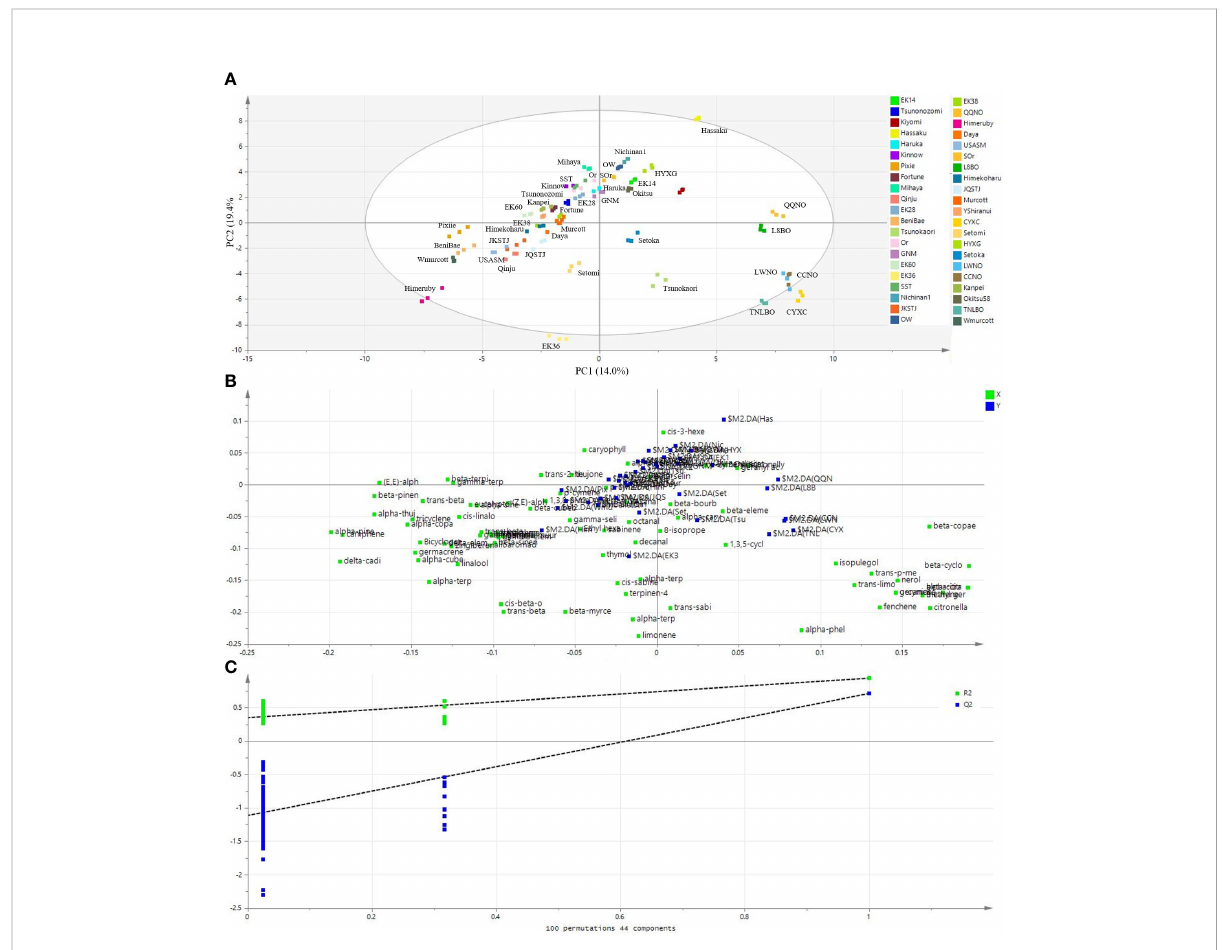
FIGURE 5 Partial least-square discriminate analysis (PLS-DA) showing a better separation amongst the 42 citrus cultivars based on their leaf volatile pro fi les. (A) A score plot of the PLS-DA results, (B) a loading plot of the PLS-DA results, and (C) statistical validation of the PLS-DA model based on permutation tests (100 permutations; 44 components). The green squares in (B) represent the volatiles that contributed to the discrimination of citrus cultivars (blue